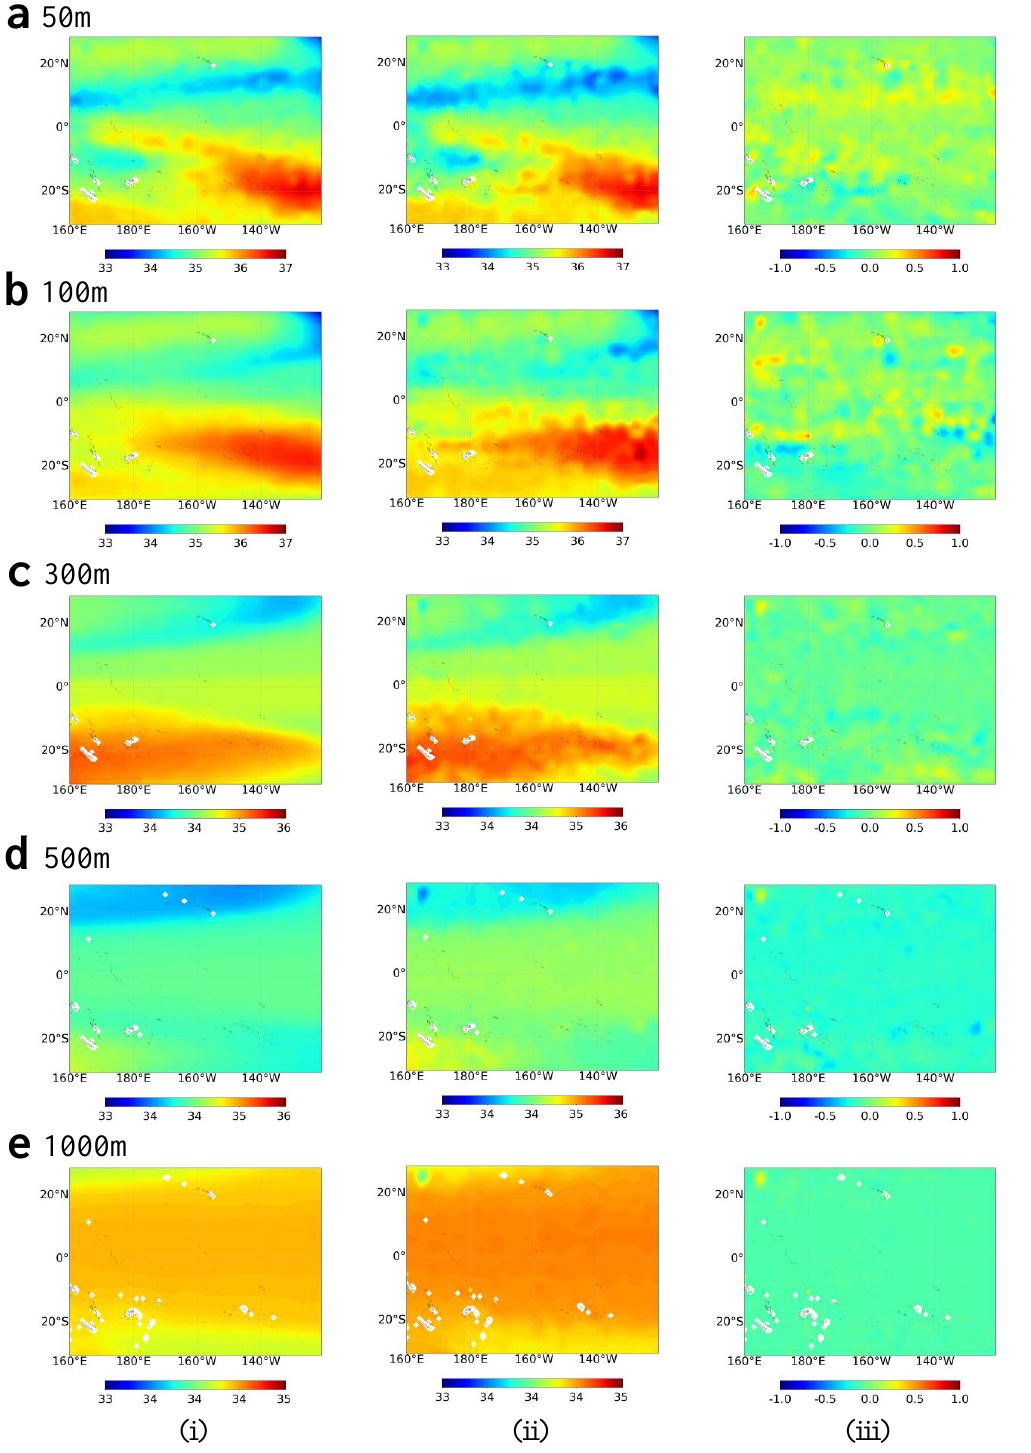
Figure 5. Spatial distribution of ConvLSTM-reconstructed SS in (i) Case 4B and (ii) Argo SS, and (iii) the absolute error of ConvLSTM-reconstructed SS at depth levels of ( a ) 50 m, ( b ) 100 m, ( c ) 300 m, ( d ) 500 m, and ( e ) 1000 m in March